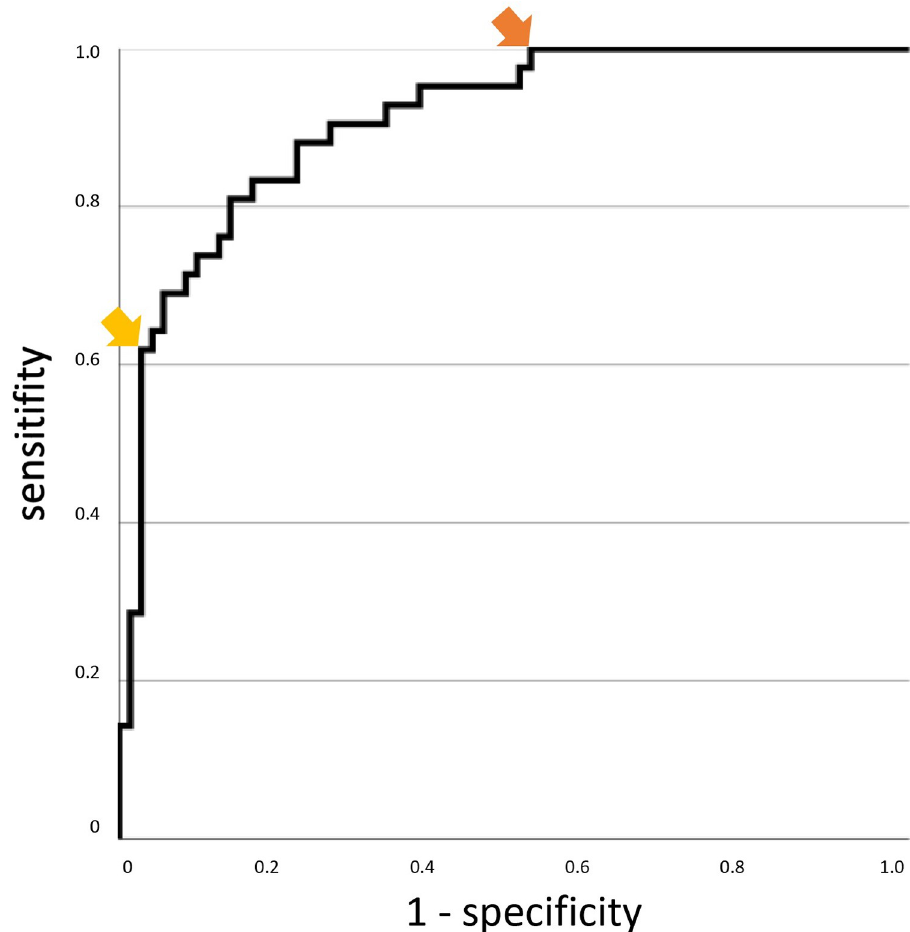
Fig 2. ROC curve for linear regression model calculated with the parameters age, average platelet count on day 10, average pump flow rate on day 10, minimum partial pressure of oxygen on day 10, and average pH on day 10 after the start of veno-venous extracorporeal membrane oxygenation. The yellow arrow is at a separation value of 0.85 with a sensitivity of 61.9 and a specificity of 97.2. Of the patient cohort considered in this study, 28 patients (25%) were above this cut-off, 26 non-survivors and 2 survivors (mortality 93%). The orange arrow marks the separation value -2.5 with a sensitivity of 100.0 and a specificity of 47.9. 34 (30%) patients in this study were below the cut-off value of -2.5, all of them survivors (mortality 0%). The group between these two cut-offs comprises 45% of the patients with a mortality rate of 31%.